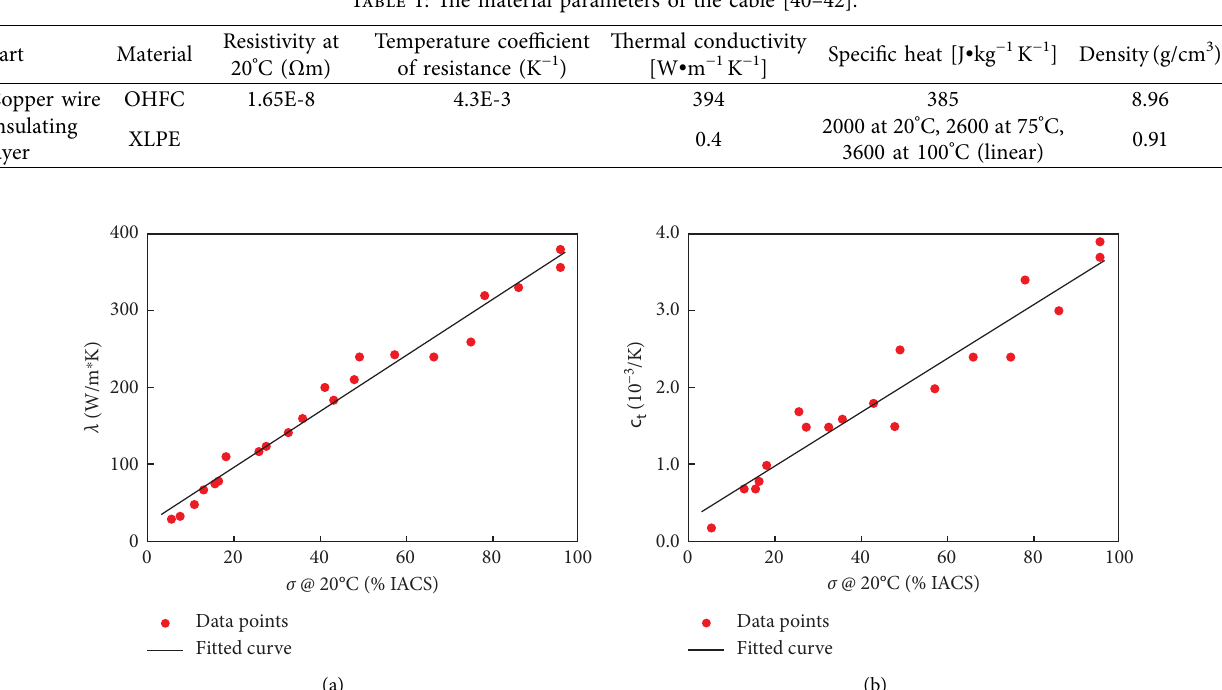
Figure 6: The relationship between λ and σ and that between c